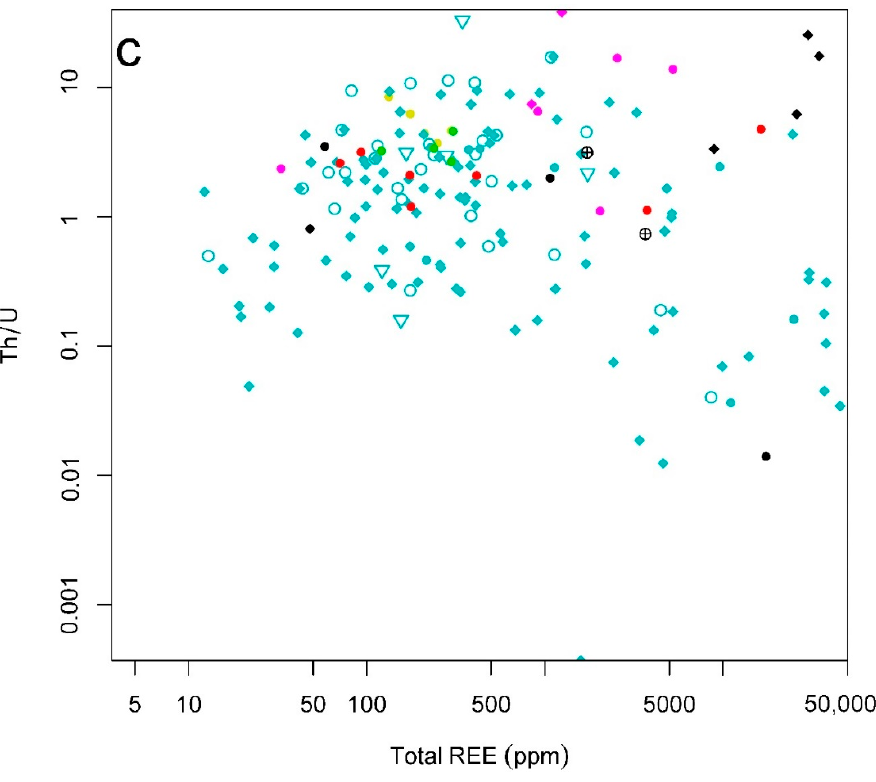
Figure 7. Binary plots of ( a ) total REE vs. Th (ppm); ( b ) total REE vs. U (ppm); ( c ) total REE vs. Th / U; for the EURARE samples (see the legend in Figure 5).